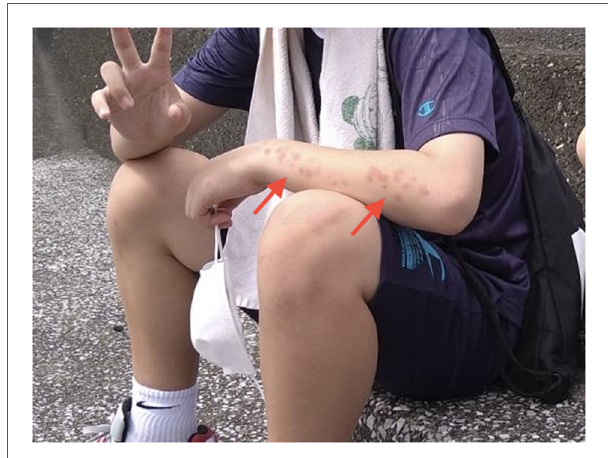
FIGURE 1 Erythematous skin rash observed on the left forearm of our patient at onset (arrows). Skin rash then spread to the other extremities and